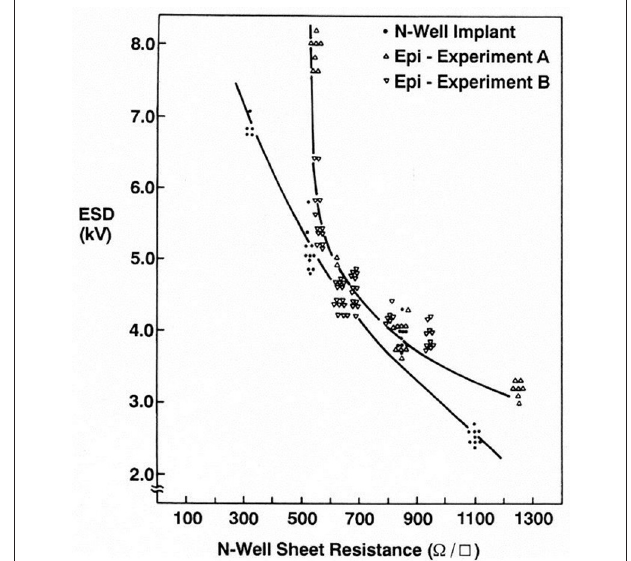
FIGURE 1 | ESD robustness as a function of retrograde n-well sheet resistance for 0.5 µ m CMOS technology (With permission from the ESD